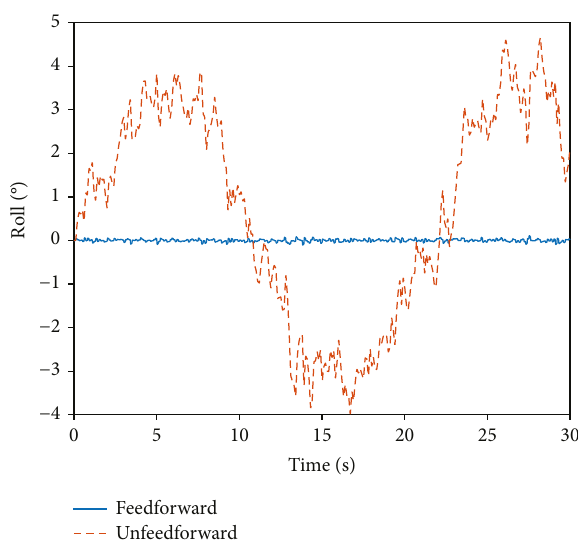
Figure 7: The feedforward and unfeedforward control with the linear